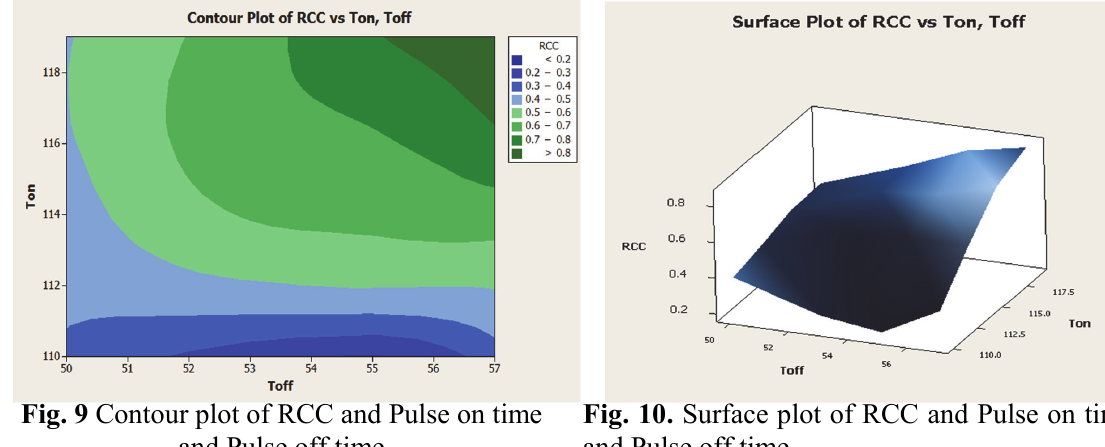
Fig. 10. Surface plot of RCC and Pulse on time and Pulse off time